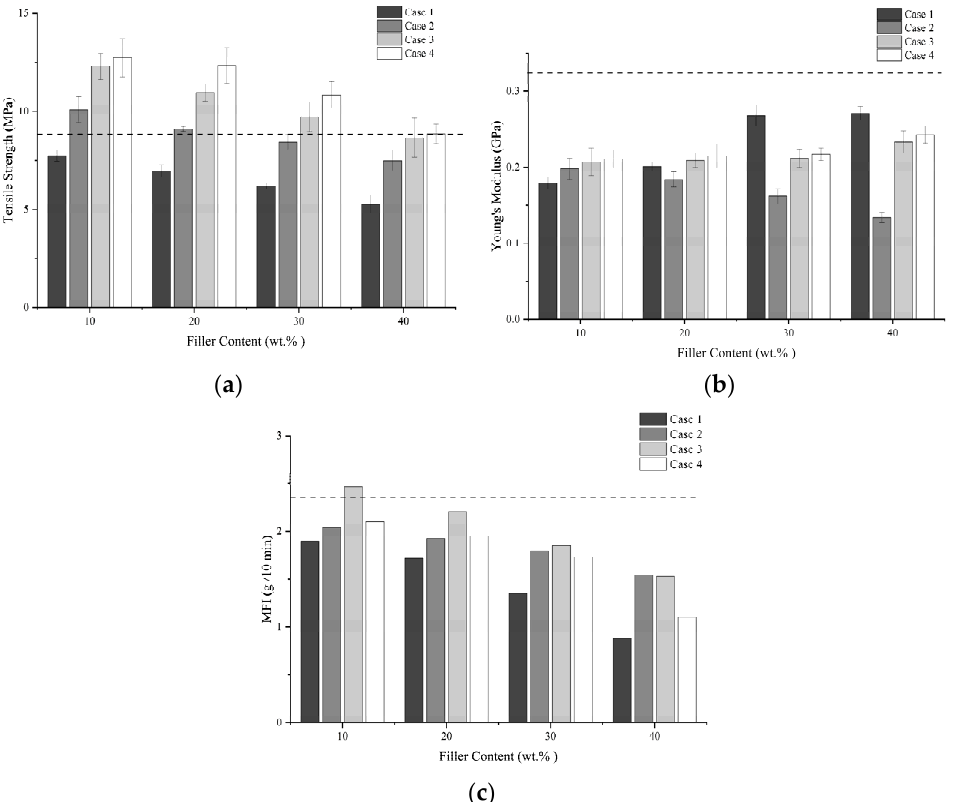
Figure 5. Tensile properties of the developed biocomposites: ( a ) tensile strength, ( b ) Young’s modulus, and ( c ) MFI values of the developed biocomposites (The dashed line represents the characteristics of LDPE).